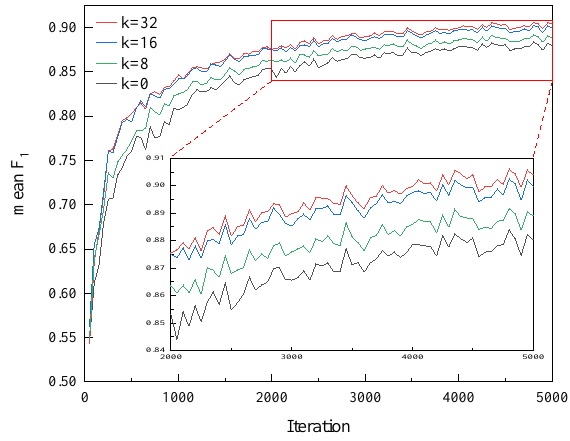
Figure 6. The mF 1 score curves for the training process with different search region k . k = 0 means the baseline